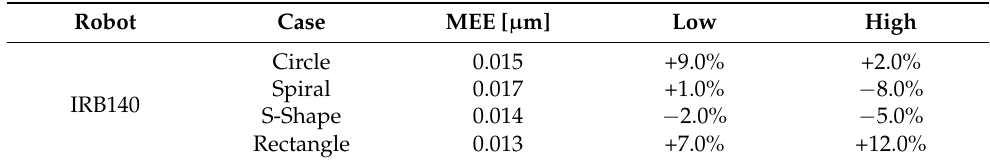
Table 3. FK error—MEE in perturbed